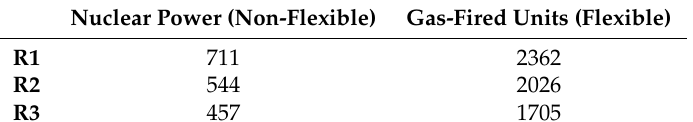
Table 3. Total operational cost for the different base-case scenarios [M e ]. Nuclear Power (Non-Flexible)